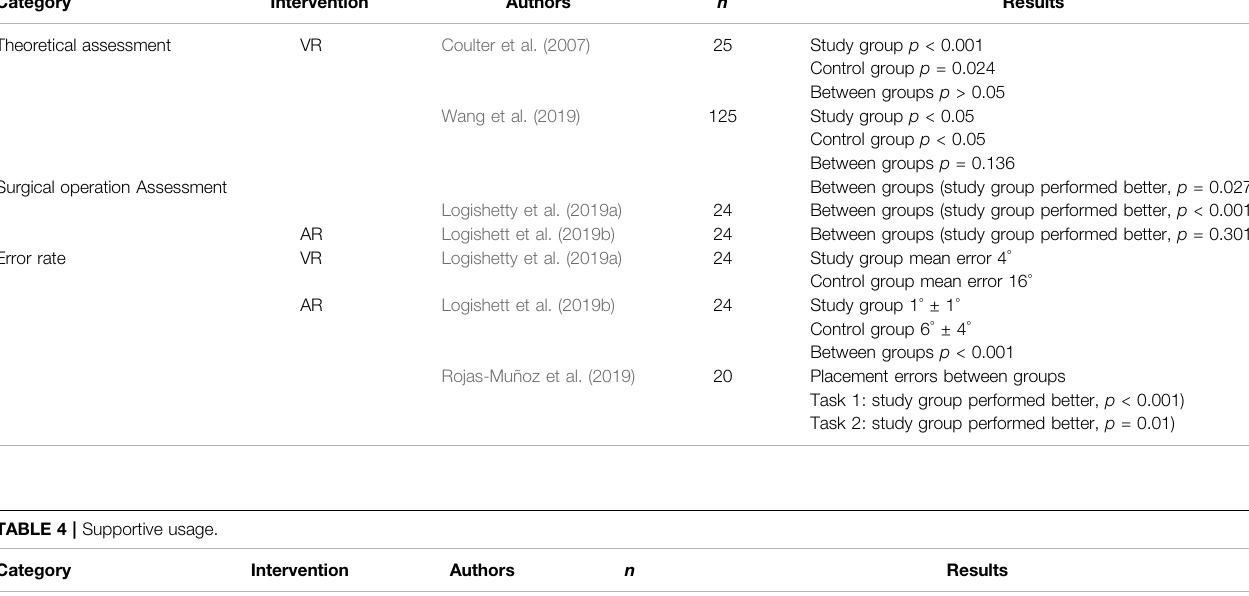
TABLE 3 | Compared with the nontraditional method.